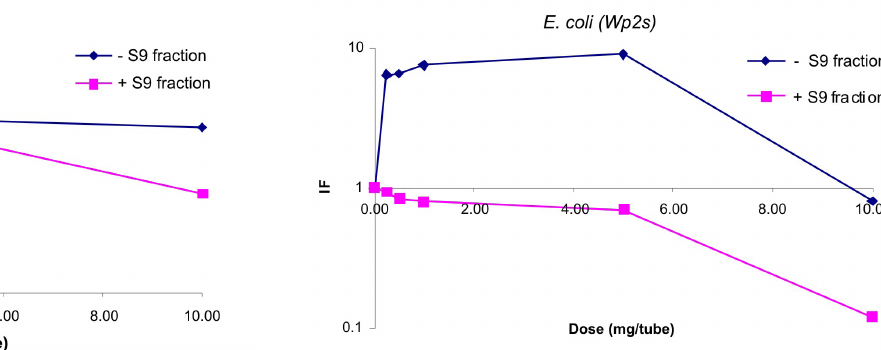
FIGURE 3 - Mutagenic Index (MI) as a function of dose (mg/tube) of “barbatimão” extract (BE), with or without S9 fraction on TA100. The maximum coefficient of variation (CV) of experiments was 10%. Plots represent average of four independent experiments.